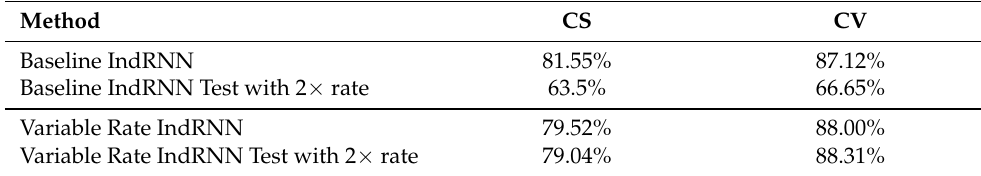
Table 1. Results of training and testing with different sampling rates.